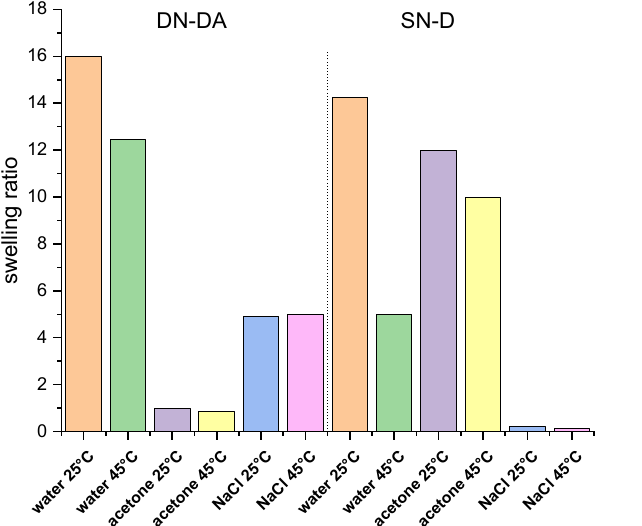
Figure 8. Equilibrium swelling ratio of the DN-DA and SN-D hydrogels in various solutions: water, acetone (100 vol.%) and 6 M solution of NaCl in water. Values of the swelling ratios are plotted for the temperatures of 25 °C and 45 °C.